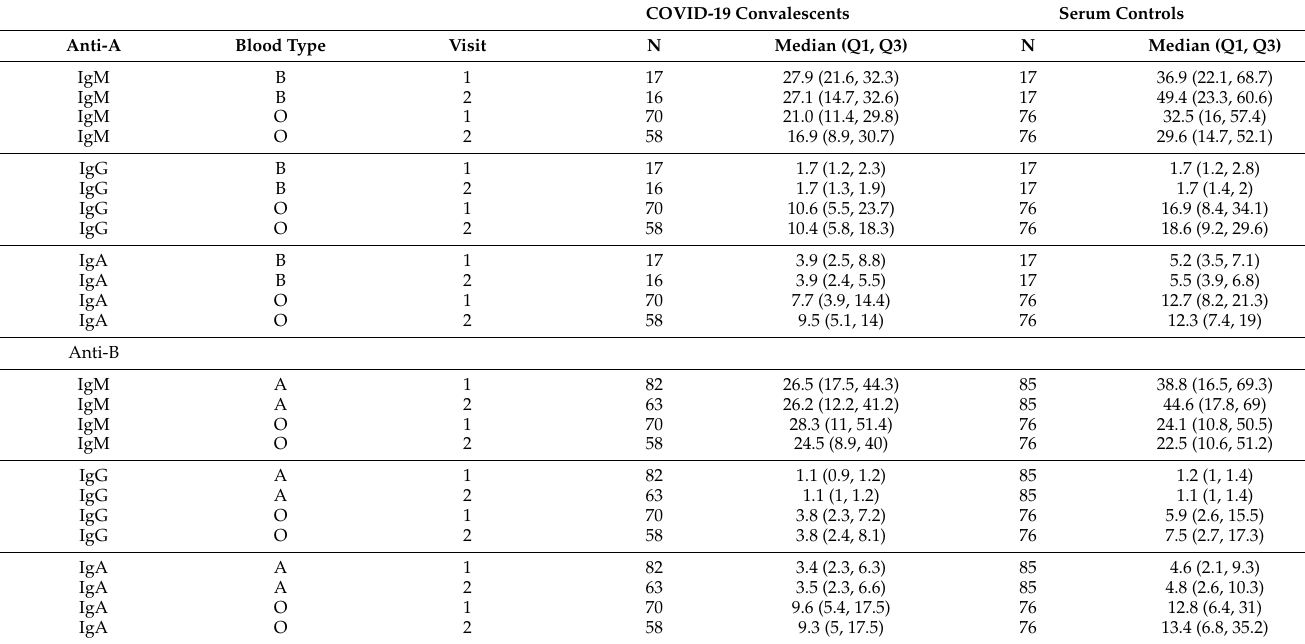
Table 2. Anti-A and Anti-B levels in the serum of COVID-19 convalescents and